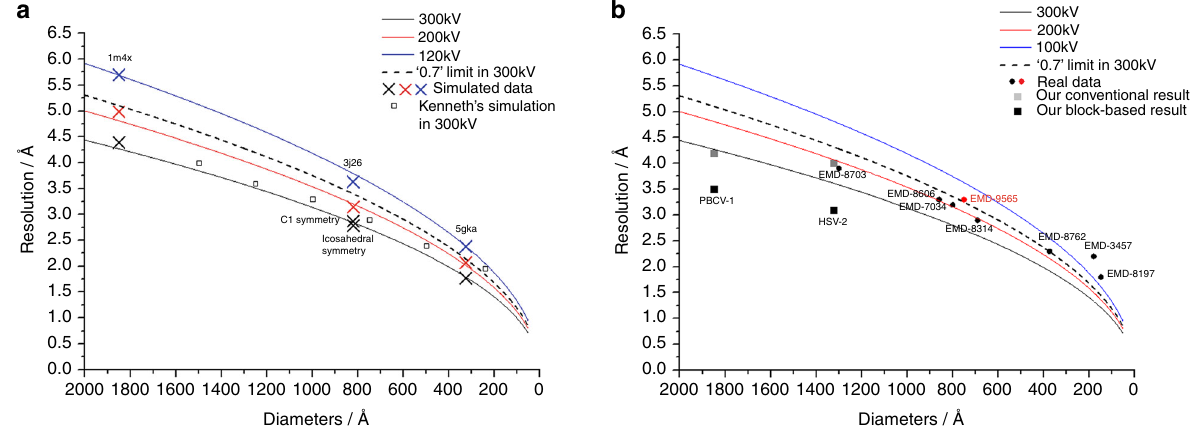
Fig. 1 The resolution limit caused by the effect of depth of fi eld. a Positions marked with a cross (x) represent the calculated resolution limit of protein complexes of variable sizes by using the simulated 300 kV (black), 200 kV (red), and 120 kV (blue) cryo-EM data. The corresponding black, red, and blue lines are the resolution limits calculated using the modi fi ed empirical formula. Values for the dashed black line were obtained by applying the DeRoiser ’ s empirical formula that was used as a reference for comparison 21, 22 . The black-edged square is the simulation result performed by Kenneth et al. 23 . b Black and red circles with EMDB codes represent the resolutions of typical high-resolution protein complexes generated by cryo-EM SPA at 300 kV and 200 kV, respectively. Black squares represent the resolutions of PBCV-1 virus and HSV-2 virus that were reconstructed by using a block-based reconstruction method. Gray squares represent the resolution of these two viruses that were reconstructed by using a conventional